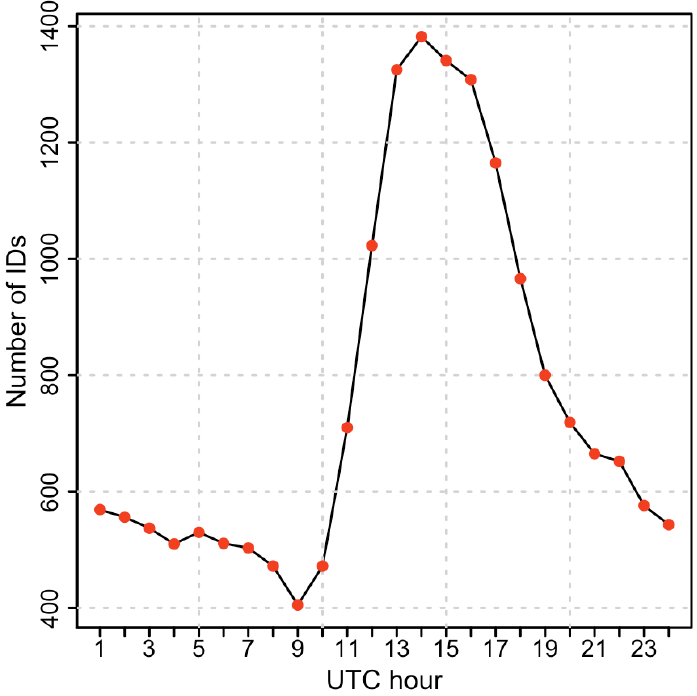
Figure 6. Distribution of the IDs during the hours of the day. Hours are expressed in universal time (UTC). To get the local time, it is necessary to add 2